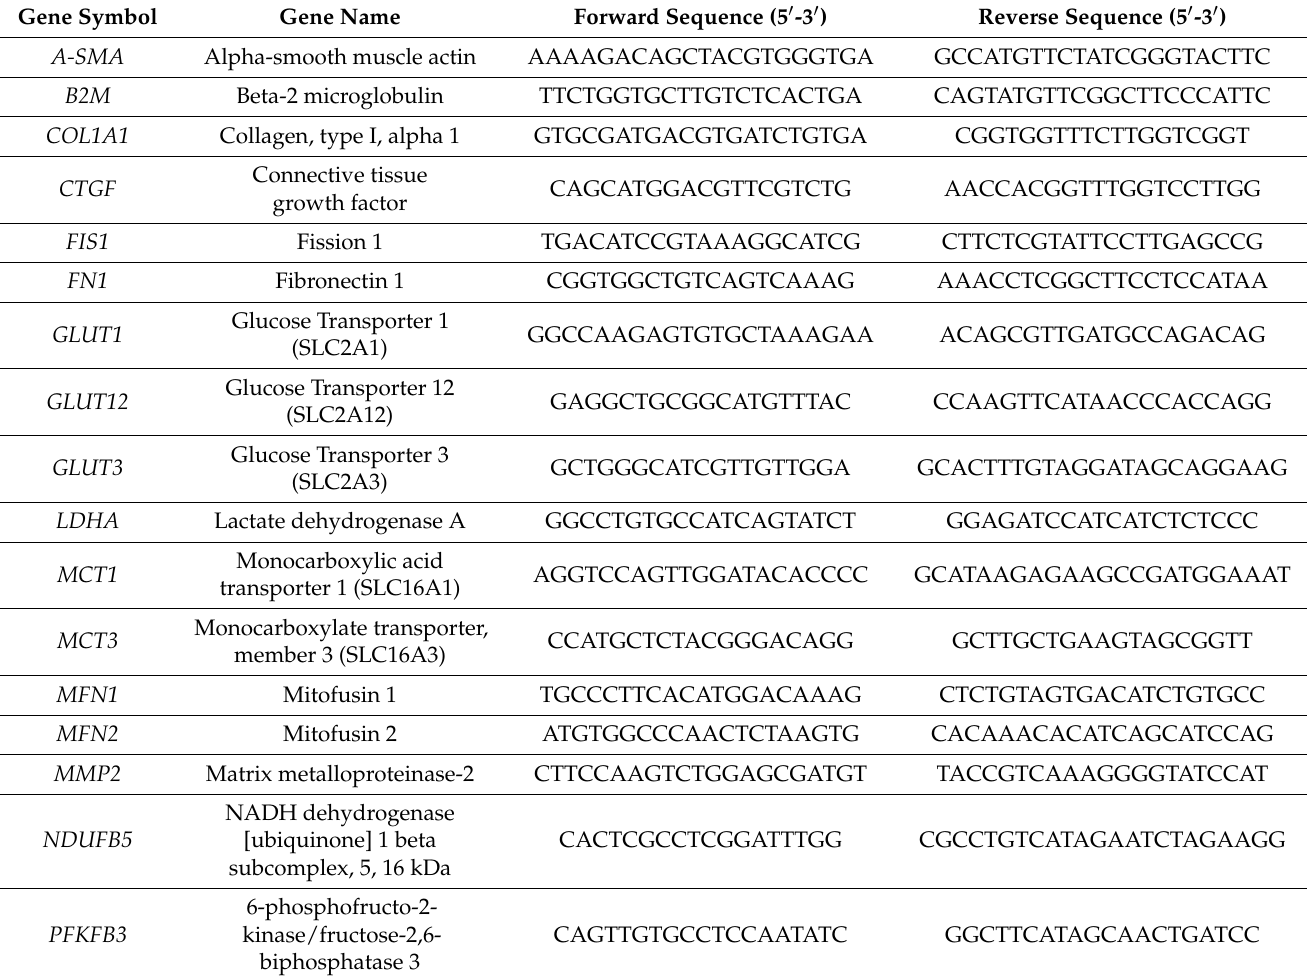
Table 1. Primer sequences for